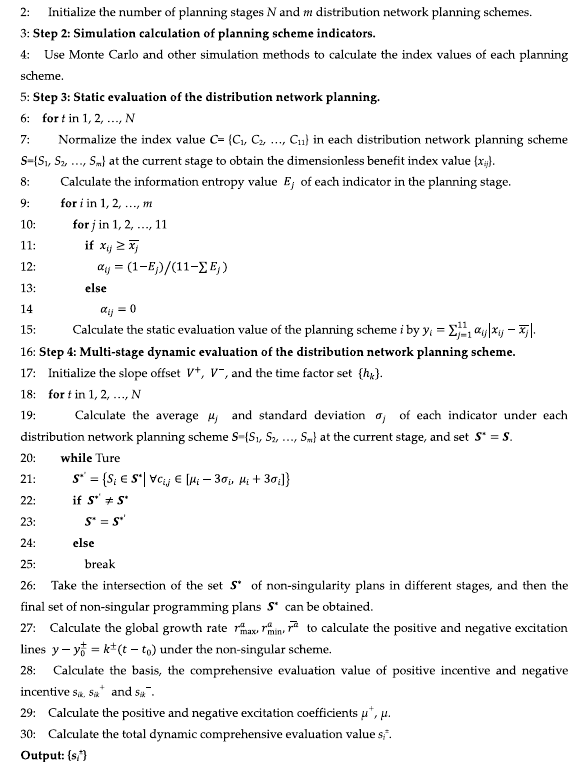
Figure 8 . The in fl uence of V − change on the negative